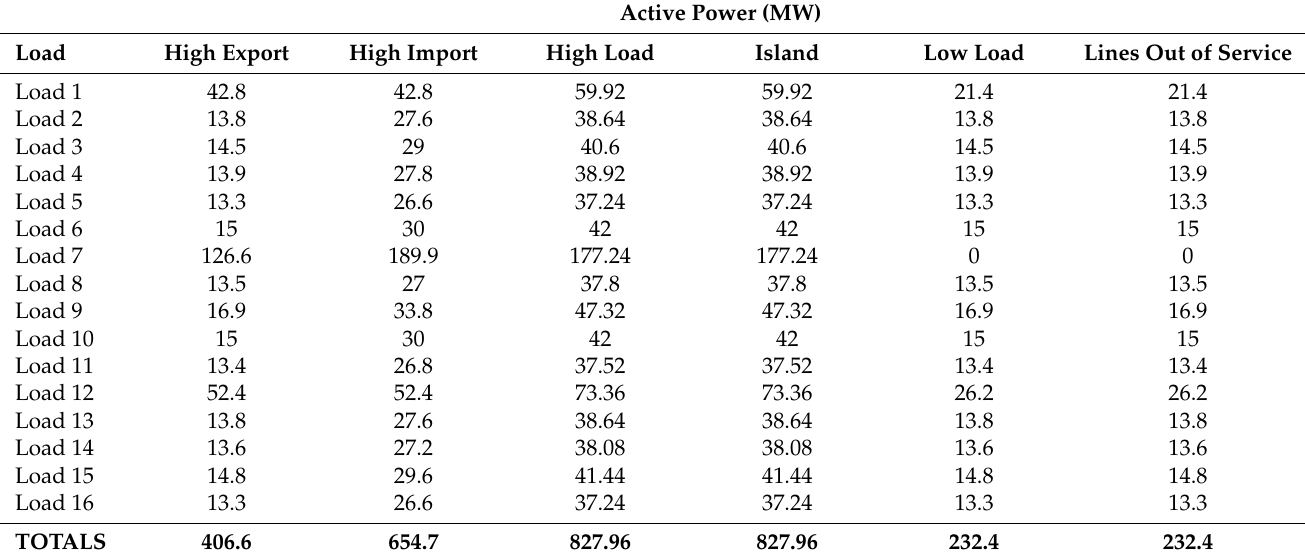
Table 7. Loads associated with the DSR